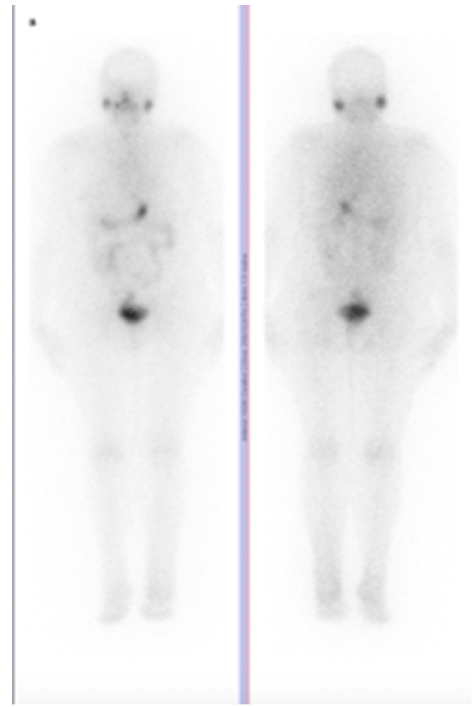
Figure 4. Whole Body Scan with I-131 sodium iodide (I-131 WBS) with 91,4 mCi (3381 GBq) at 48 h postadministration, with no pathological uptake.(anterior, left , posterior, right ) (2019).